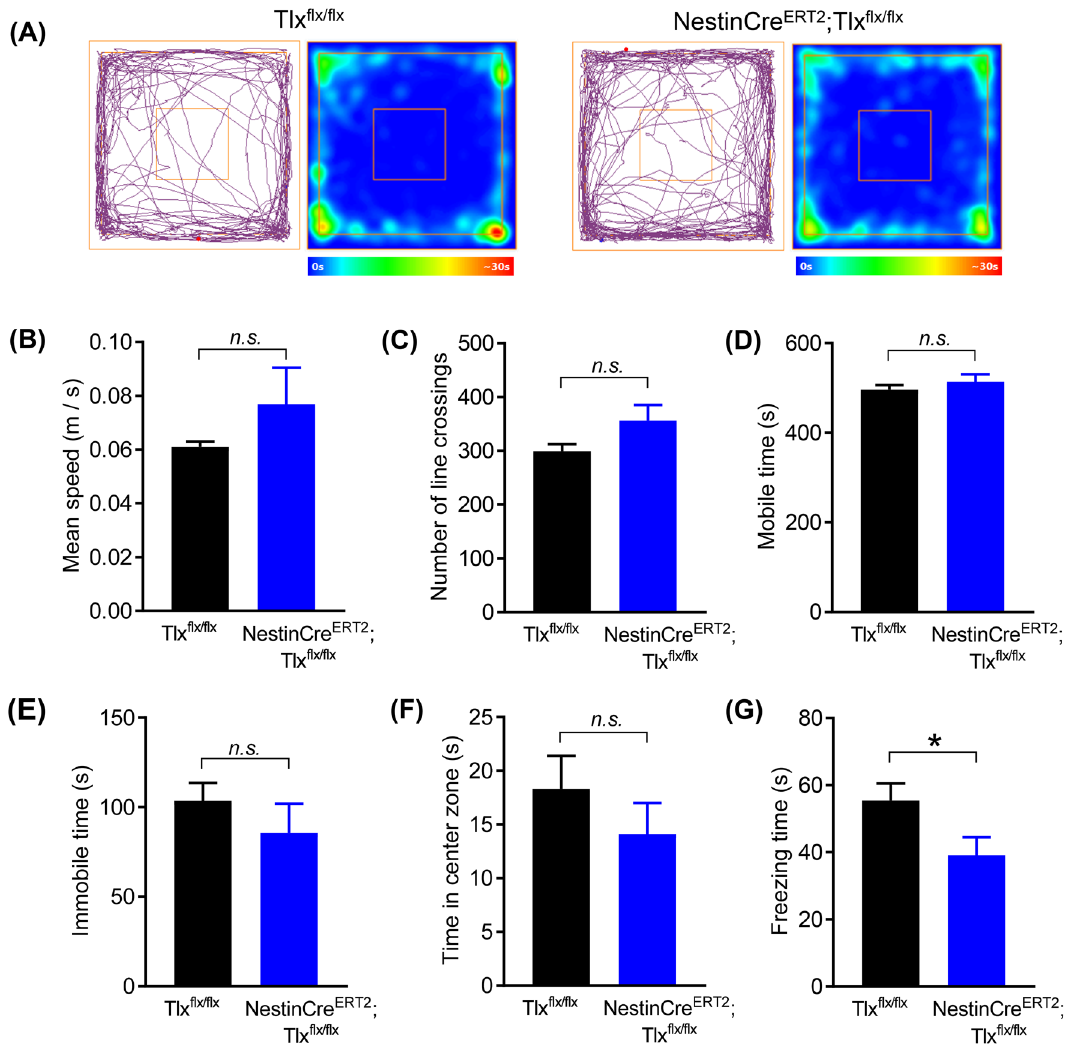
Figure 4. ( A ) Example track plots and heat time maps of exploratory behaviour and locomotion in the open field test at late stage SNI. ( B–G ) Locomotive behaviors assessed from the open field test—mean speed ( B ), number of line crossings ( C ), time spent mobile ( D ), time spent immobile ( E ), time spent in the open center zone ( F ) and total freezing time ( G ). * p < 0.05, unpaired t-test ( B–G ); n.s. not